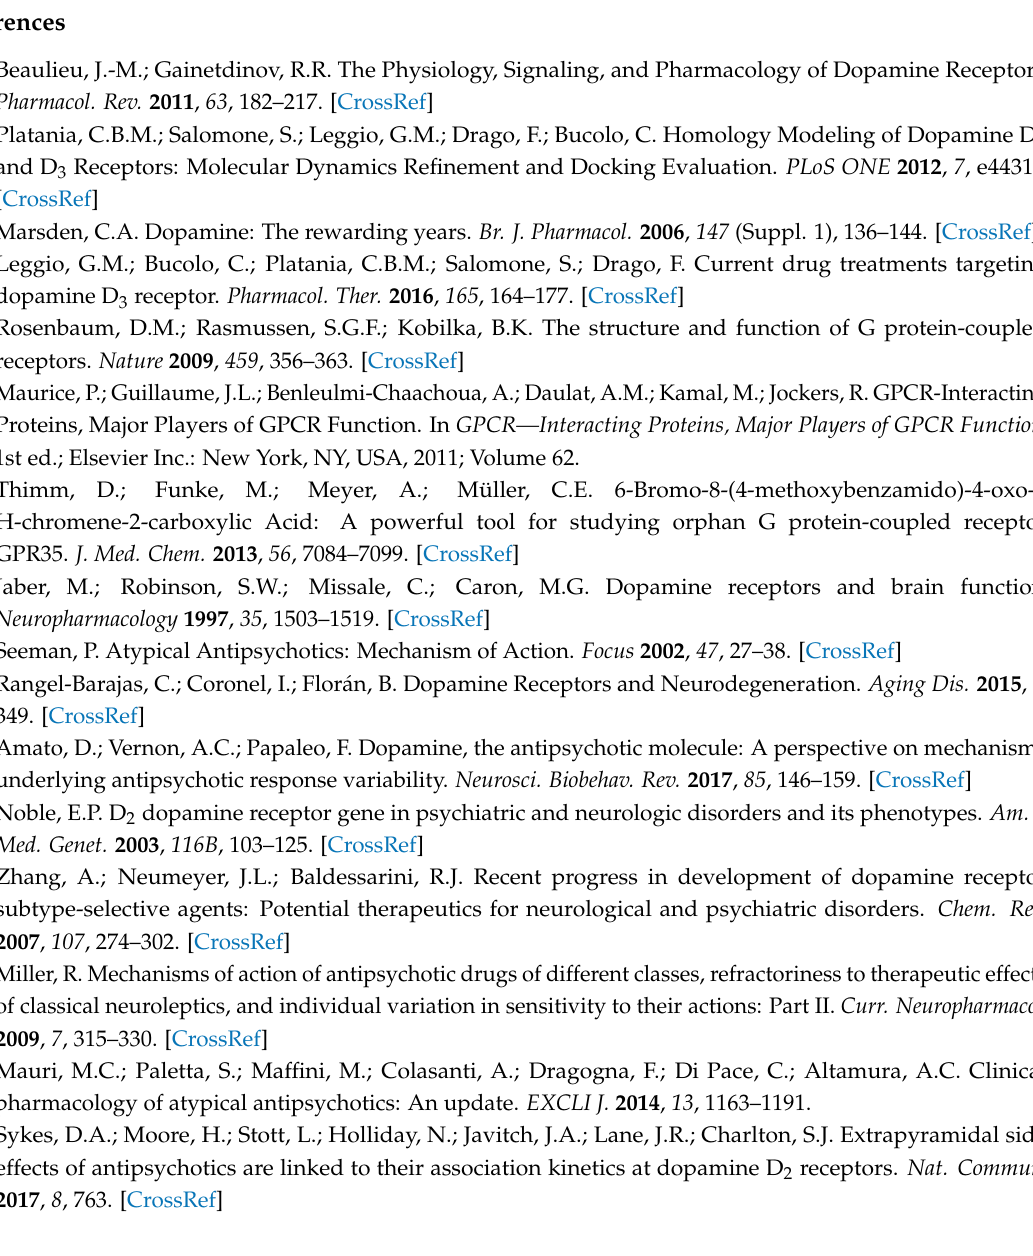
Table S13—D 4 R residues with Ballesteros & Weinstein-numbering participating in different interaction types sorted by ligands; Table S14—D 5 R residues with Ballesteros & Weinstein-numbering participating in different interaction types sorted by